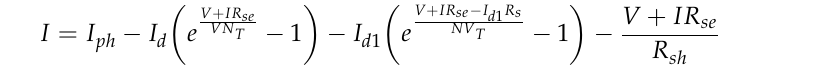
Figure 3. Schematic diagram of the modified double-diode PV model.